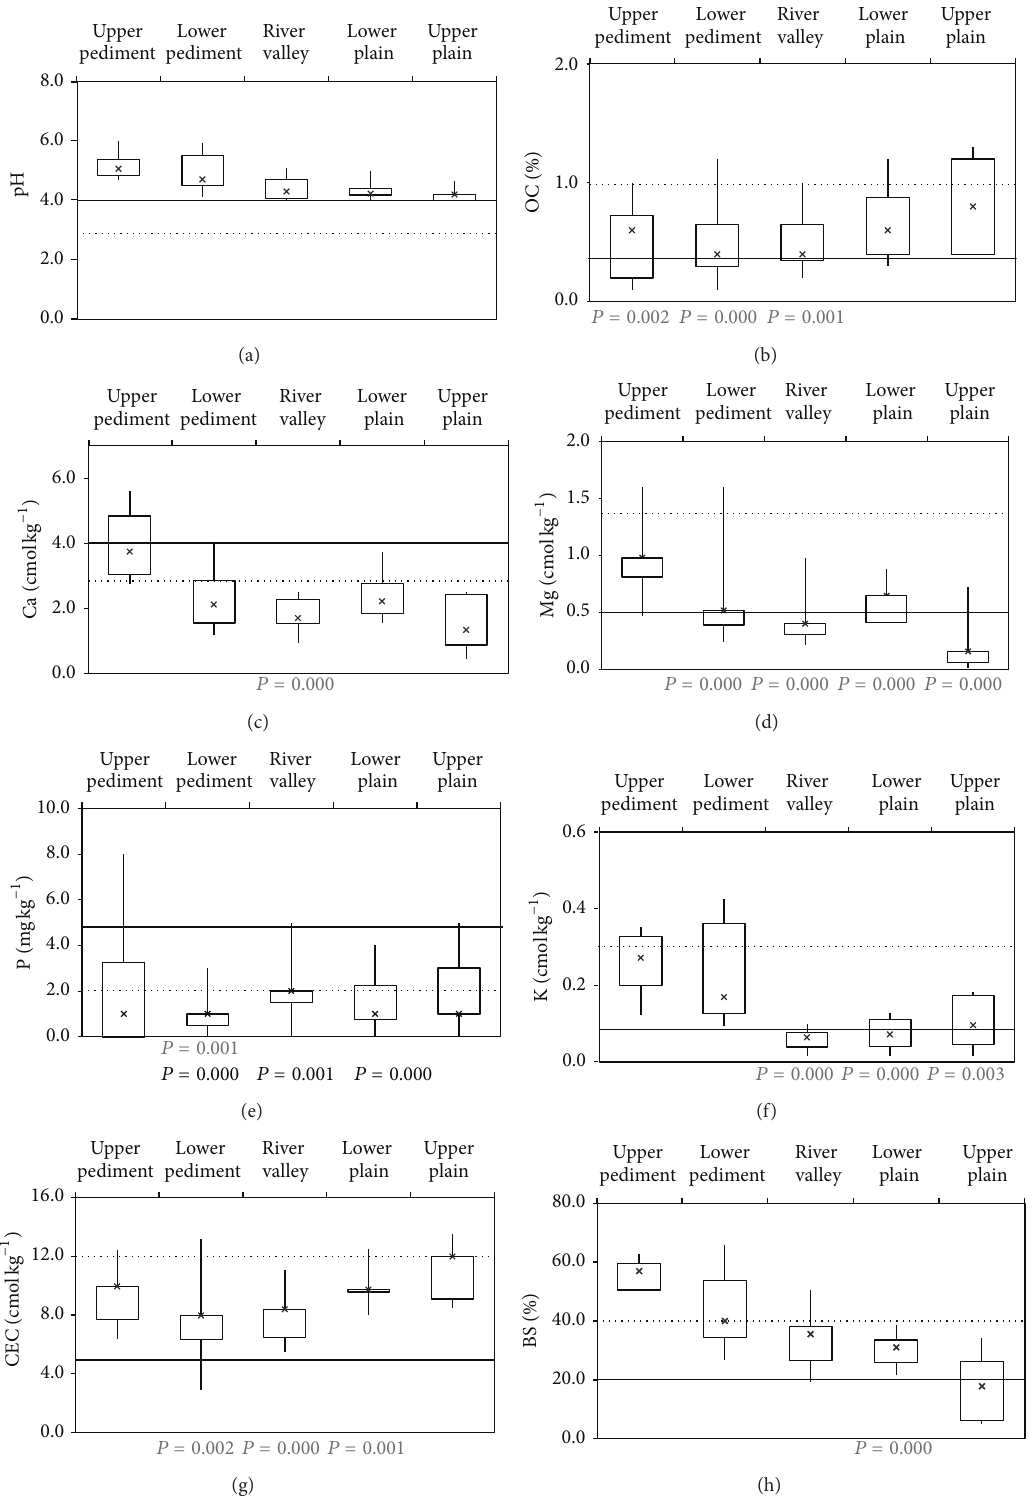
Figure 2: pH values, OC contents, Ca, Mg, K, and P concentrations as well as BS and CEC in soils of the Kaduna study area compared to West African background levels and critical limits. Boxplot diagrams show chemical characteristics of the Kaduna study area soils that have developed on upper pediments, lower pediments, river valleys, lower plains, and upper plains, respectively. Dotted lines represent West African background values, while solid lines show the critical limits both as given by Jones and Wild [19], Landon [20], Vanlauwe et al. [21], Raji et al. [22], Agbenin and Yakubu [23], Esu and Ojanuga [24], and Valette and Ibanga [25]. Grey 𝑃 values indicate statistically significant differences between the pH, OC, Ca, Mg, K, P, BS, and CEC of the soils in the Kaduna study area and the West African background values. Black 𝑃 values indicate statistically significant differences between the Kaduna soil fertility parameters and the critical